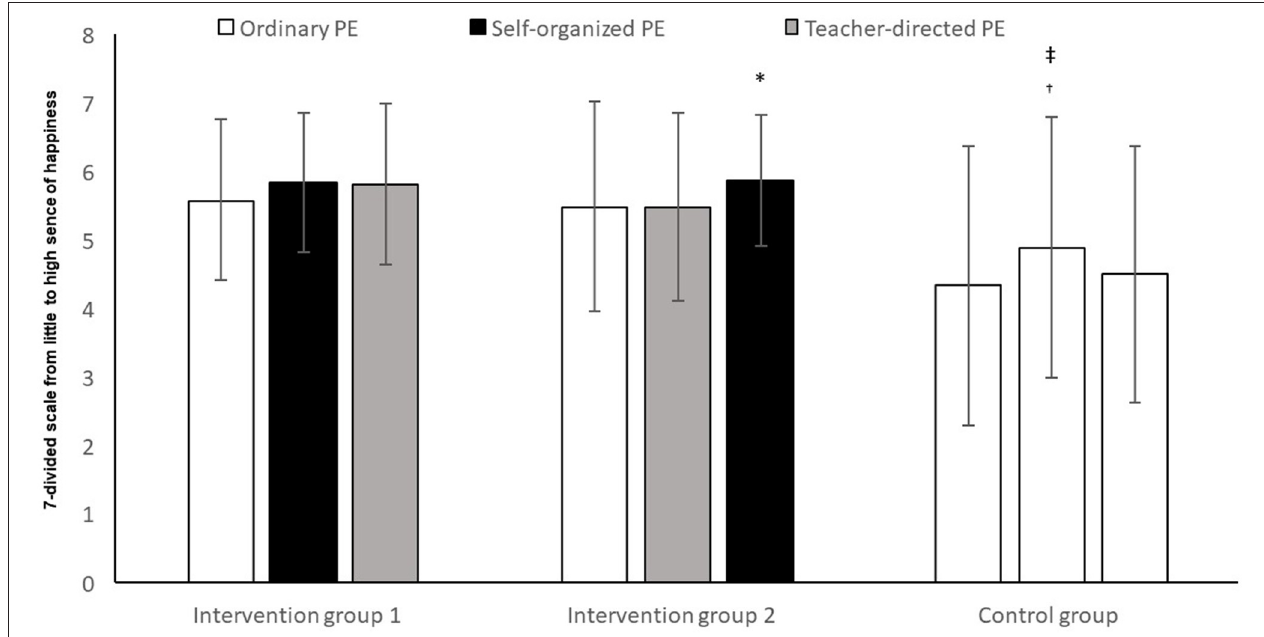
FIGURE 3 | Perception of happiness among pupils in ordinary PE, teacher-directed PE and self-determined PE after 3 time periods. *Significantly higher perception of happiness in self-determined PE compared to teacher-directed PE ( p < 0.05). † Significantly lower perception of happiness in the control group, compared to intervention groups 1 and 2 ( p < 0.05). ‡ Significantly higher perception of happiness in the control group in T2 compared to T1 ( p <